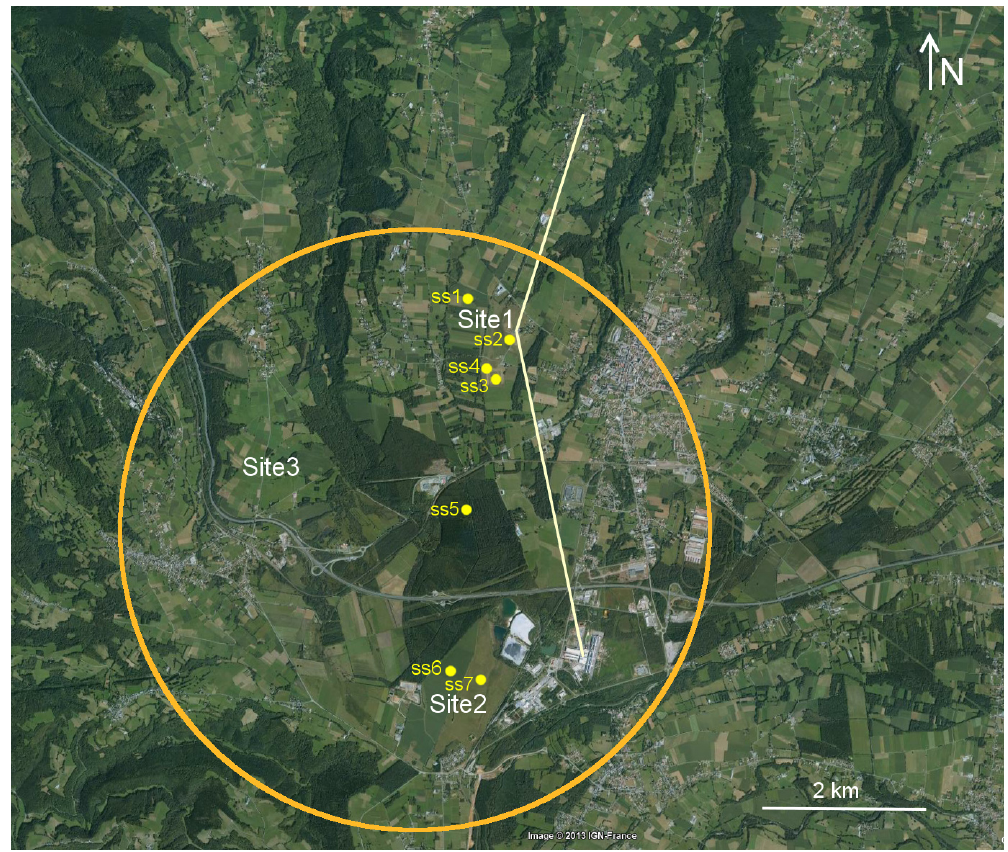
Figure 2. Satellite view (from Google Earth) of the area, showing the instrumented site locations. Surface sites over various vegetation are noted ss1 to ss7: (ss1) wheat, grass and edge; (ss2) prairies; (ss3) micro-scale surface heterogeneities; (ss4) 60m tower; (ss5) forest; (ss6) maize; and (ss7) moor. The light yellow lines represent the paths of the two large aperture scintillometers and the orange circle indicates the limit of the